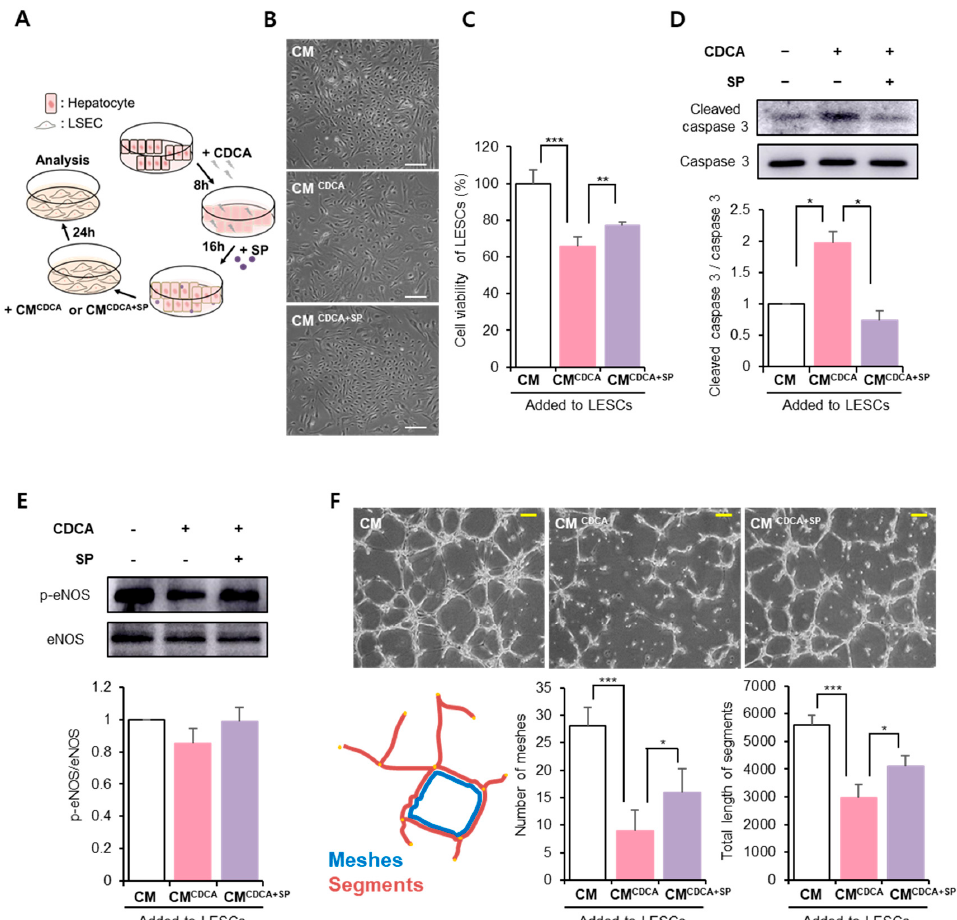
Figure 4. SP ameliorates LSEC injury due to secretory factors from CDCA-damaged HepG2 cells. ( A ) In order to check the effect of secretory factor of hepatocyte on function of LSECs, CM, CM CDCA , and CM CDCA+SP were added to LSEC in a ratio of 1:1. ( B ) LSEC morphology was comparatively observed 24 h later. Scale bar: 200 µm ( C ) LSEC viability was evaluated via the WST-1 assay, and it is shown relative to the control-CM group. ( D ) Protein levels of cleaved caspase-3 in LSEC were analyzed via Western blotting and expressed relative to total caspase-3. ( E ) Protein levels of phospho-endothelial nitric oxide synthase (eNOS) were determined via Western blotting, and its expression level is shown relative to total eNOS. ( F ) LSEC ability to form a tubular structure was assessed on Matrigel, and quantification based on meshes and segments was carried out. CM: Conditioned medium of HepG2, CM CDCA : Conditioned medium of HepG2 with CDCA, CMCD CA+SP : Conditioned medium of HepG2 with CDCA and SP; Meshes: full reticulated tubes; segments: the tubes completely connected to each other. The values shown are the means ± standard deviations of three independent experiment, * p < 0.05, ** p < 0.01, *** p < 0.001. Compared to the control (HepG2 CM), CDCA-treated HepG2 CM (CM CDCA ) expanded the cell size of LSECs with a low proliferation rate, but SP-treated CM (CM CDCA+SP CM CDCA on LSECs (Figure 4C, Control: 100% ± 7.51%, CM CDCA : 68.26 ± 0.25%, CM CDCA+SP : 77.21 ± 1.21%, CM CDCA vs. CM CDCA+SP p < 0.01). Notably, CM CDCA activated cleaved caspase- cleaved caspase-3 expression.